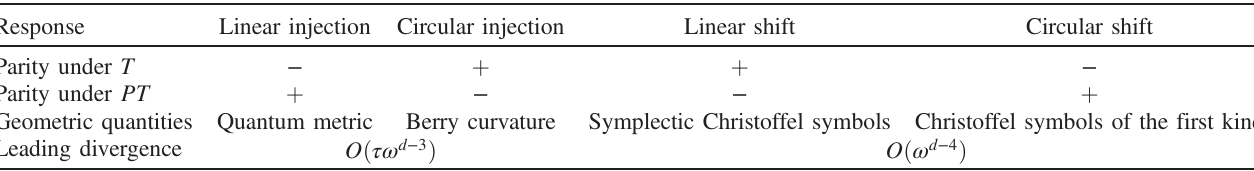
TABLE I. Low-frequency properties of second-order dc photovoltaic responses. Linear and circular indicate the polarization of light. Injection and shift conductivities are defined by Eq. (4). The sign (cid:1) indicates the parity of the conductivity tensor under the action of time reversal T and spacetime-inversion PT . See Eqs. (9) and (10). In T - ( PT -) symmetric systems, only the responses with the positive T - ( PT -) parity appear. All four responses can appear when T and PT symmetries are both broken. Based on their symmetry properties, we call the linear injection and circular shift current responses PT -symmetric responses and the linear shift and circular injection current responses T -symmetric responses. Symplectic Christoffel symbols indicate the symplectic analog of the Christoffel symbol of the first kind [see Eq. (33)]. Here, we consider only interband-transitive processes in the clean limit, where the relaxation rate Γ ¼ τ − 1 is smaller than the photon frequency ω . In this case, the injection current is typically larger than the shift current, and they become comparable when ω approaches Γ .